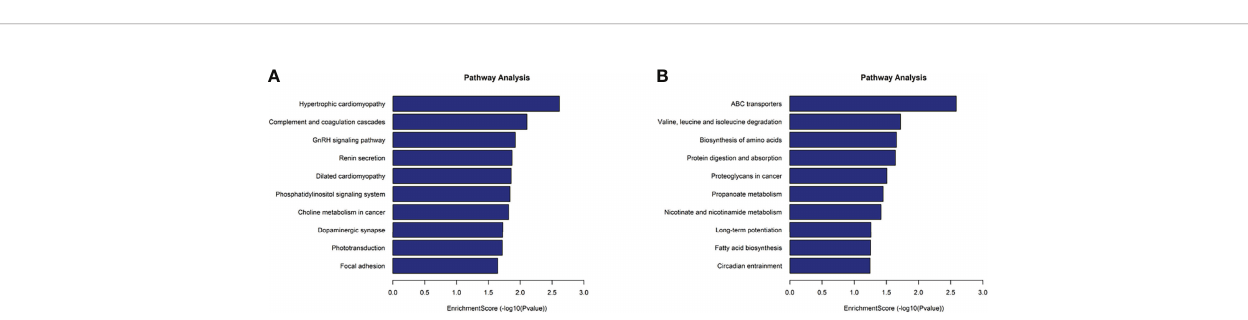
FIGURE 5 | KEGG analysis on different m7G methylation genes of HL60 and HL60/MX2 cells. (A) Major enriched KEGG pathway of up-methylated m7G in HL60- MX2 cells. (B) Major enriched KEGG pathway of down-methylated m7G in HL60-MX2 cells.